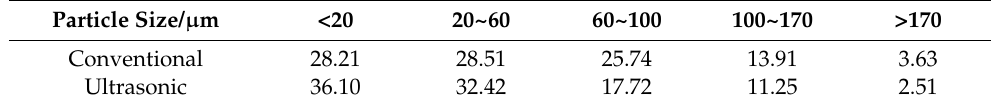
Table 4. Leaching residue particle size composition analysis (%).